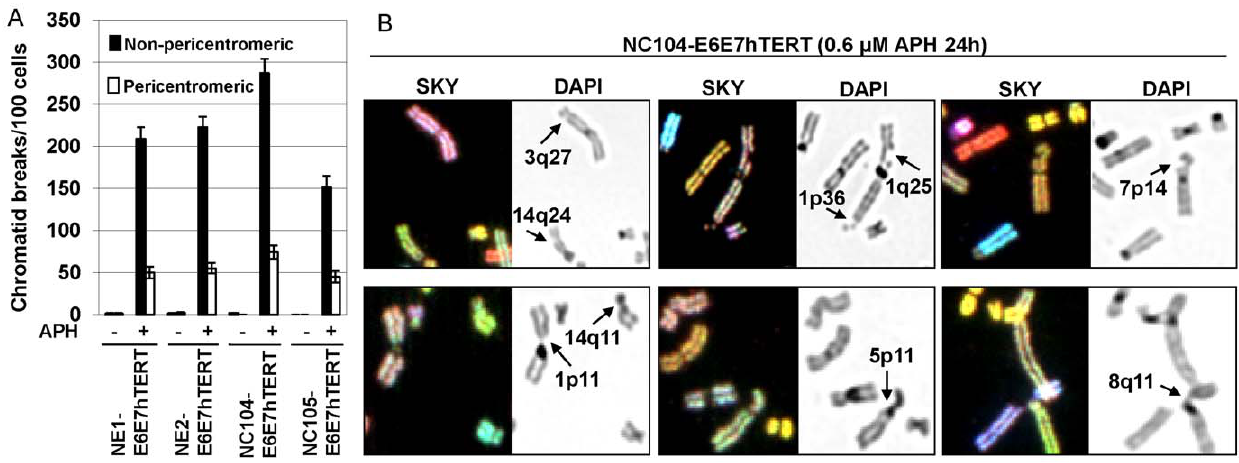
Figure 2. Chromatid breaks induced by APH treatment. A: Frequencies of chromatid breaks measured at the end of APH ( + ) or DMSO ( 2 ) treatment. P # 0.05 for all frequencies after APH treament compared with DMSO-treated cells. B: Examples of chromatid breaks (indicated by arrows). The upper panel shows non-pericentromeric chromatid breaks in fragile sites. The lower panel shows pericentromeric chromatid breaks.